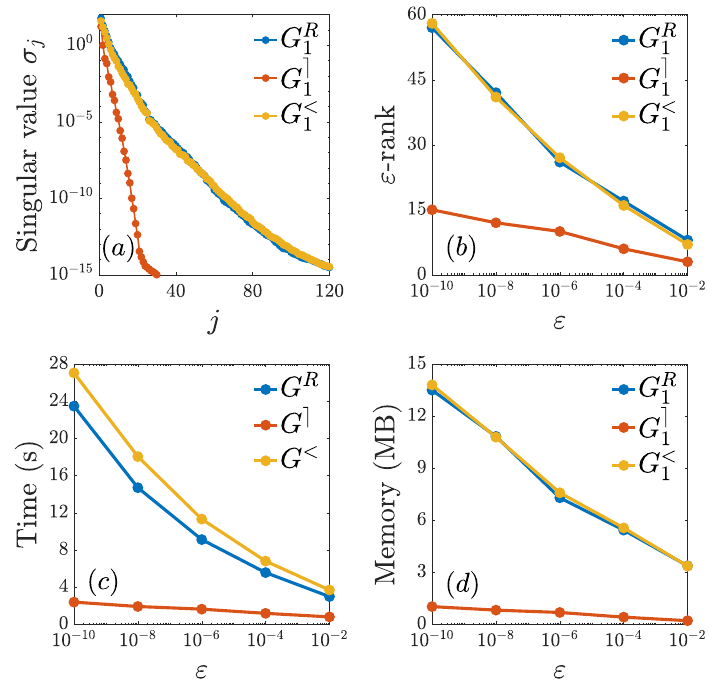
Figure 6: Varying the SVD truncation tolerance (cid:34) for the Floquet example with prop- agation time T = 64, corresponding to N = 4096 time steps.The plots are analogous to those shown for the ramp example in Fig.